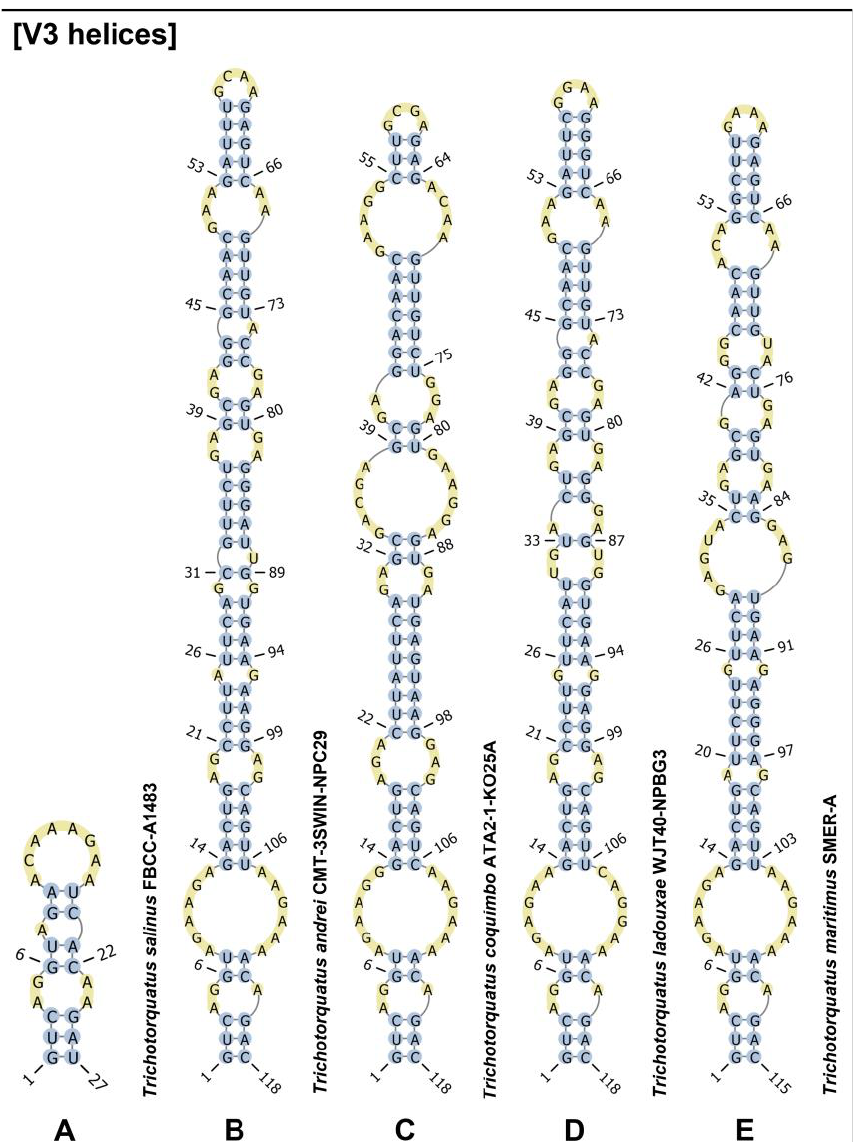
Figure 7. Secondary structures for the V3 (type 2 operon) in the conserved regions of the 16S–23S internal transcribed spacer region. ( A ) Trichotorquatus salinus FBCC-A1483; ( B ) T . andrei CMT-3SWIN-NPC29; ( C ) T . coquimbo ATA2-1-KO25A; ( D ) T . ladouxae WJT40-NPBG3; ( E ) T . maritimus SMER-A. These structures were drawn considering Pietrasiak et al.